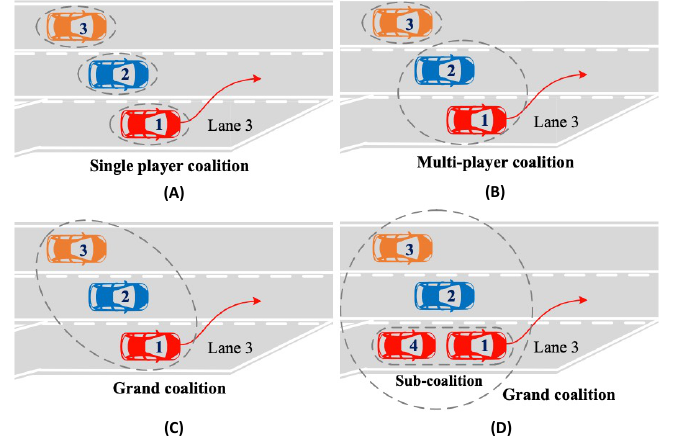
Figure 7. Four types of coalitions. ( A ) The single player coalition; ( B ) The multi-player coalition; ( C ) The grand coalition; ( D ) The grand coalition with a